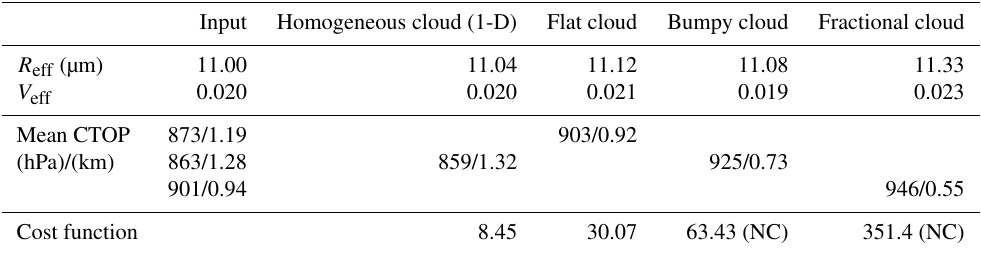
Table 2. Retrieved cloud droplet effective radius ( R eff ), effective variance ( V eff ) and cloud top altitude (CTOP) from polarized reflectances with an optimal estimation algorithm. First column is the input, second column the retrieval for the homogeneous cloud (1-D), third column for the flat cloud, fourth column for the bumpy cloud and fifth column for the fractional cloud. The last line is the final cost function with NC meaning no convergence. The solar zenith angle is 60 ◦ . Note that the cloud top altitude is different according to the heterogeneous cloud leading to three different